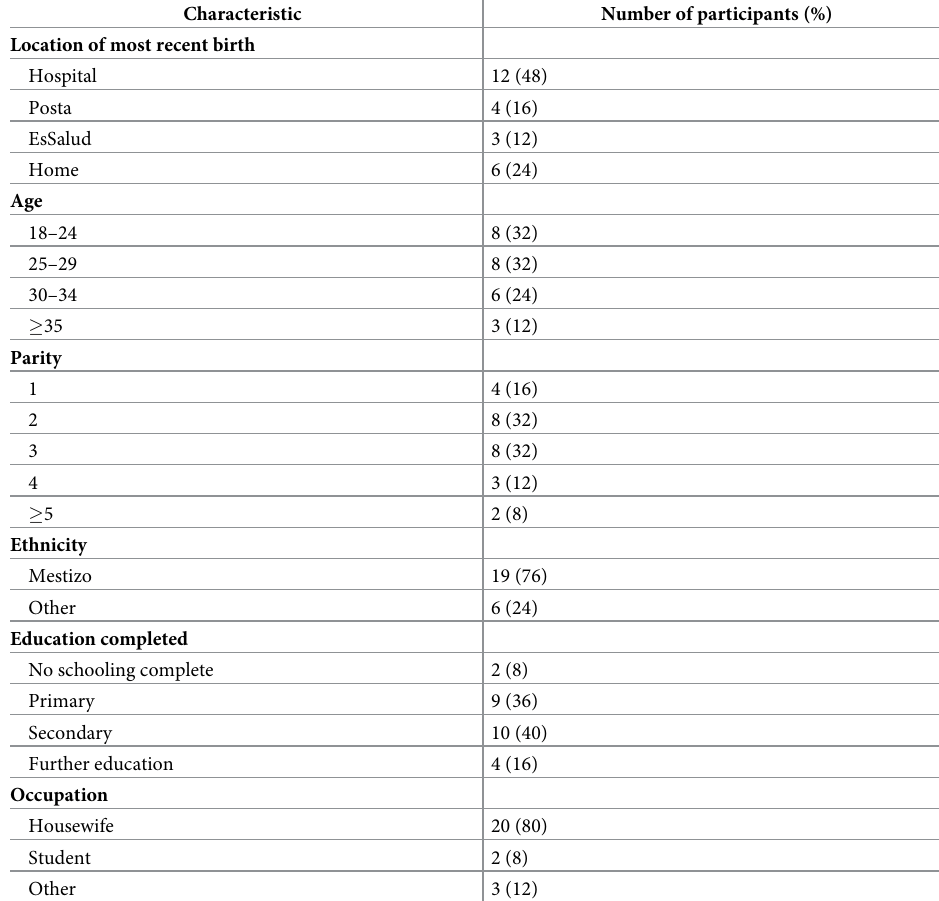
Table 2. Socioeconomic characteristics of